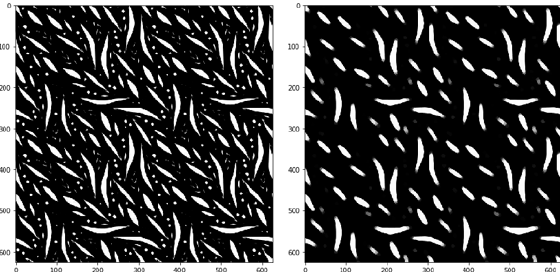
Figure 6. (a) True colour S2 image, composited by B4-B3-B2 acquired by 18 Nov 2019; (b) false colour S2 image to highlight the bushfire burn areas, composited by B12-B8A-B4; (c) RBR